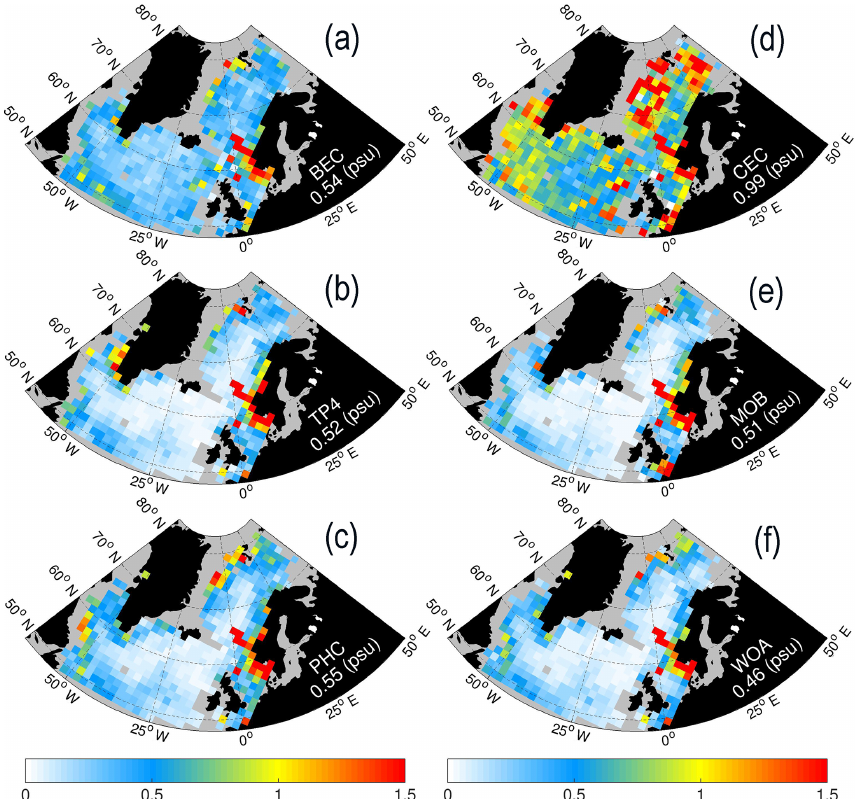
Figure 10. The root mean square deviation of SSS for six datasets compared to in situ observations from CORA 5.1 during the 3 years of 2011–2013 in the northern North Atlantic and the Nordic Seas. The SSS observations are distributed across the coarse grid cells of 9 × 9 grids in TP4, with a gray mask if the valid observations are fewer than 10.